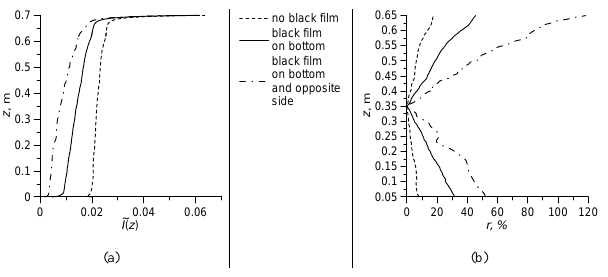
Fig. 11 Fig. 11. Relative intensity ˜ I(z) in the direction (cid:127) ∗∗ (a) and the de- viation r(z) (b) at the vertical wall AB of the homogeneous snow- Fig.12 Fig. 12. Relative intensity ˜ I(z) in the direction (cid:127) ∗∗ (a) and the de- = 0 . 98, the width pack. The snow single scattering albedo ω snow 0 viation r(z) (b) on the vertical wall AB of the heterogeneous snow- D = 1m, and depth H = 0 . 7m , with and without black film. pack. Single scattering albedo ˜ ω 0 = 1 out of the inserted polluted layer, width D = 1m, depth H = 0 . 7m, and no black film, for the different values of the thickness t of the inserted polluted layer. 30